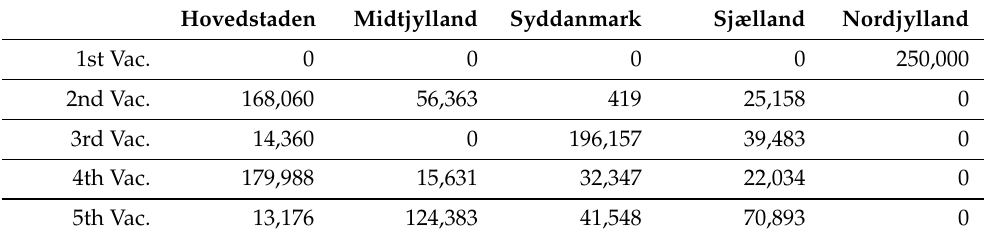
Table 11. Best vaccination plan obtained from SEAIRV model.